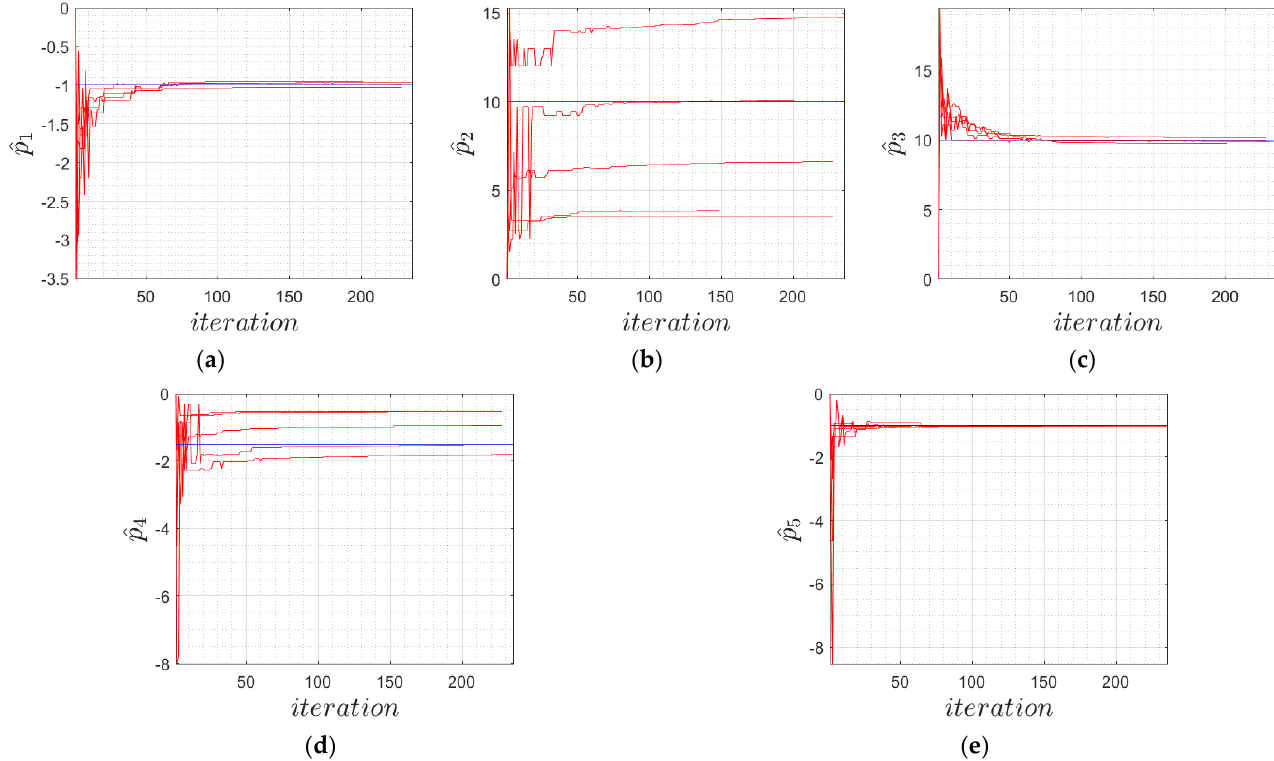
Figure 4. Convergence of the estimated parameters using GA optimization. ( a ) 𝑝̂ 1 convergence, ( b ) 𝑝̂ 2 convergence, ( c ) 𝑝̂ 3 convergence, ( d ) 𝑝̂ 4 convergence, ( e ) 𝑝̂ 5 convergence.